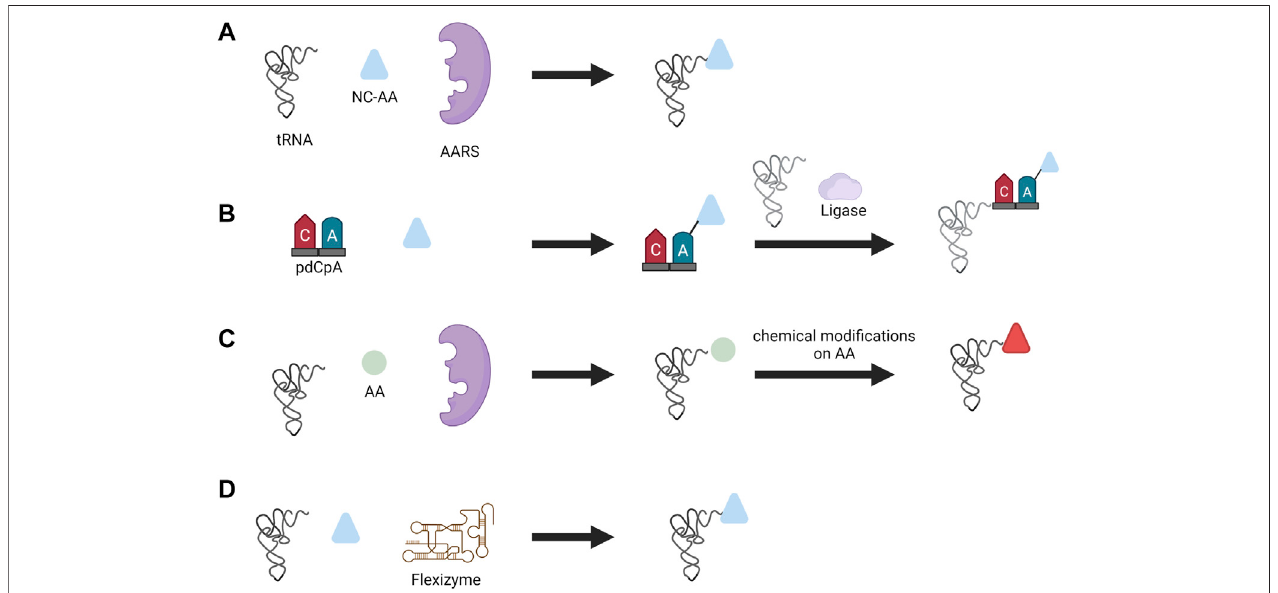
FIGURE 5 | Different aminoacylation methods used for NC-AA incorporation. (A) Enzymatic aminoacylation by AARS, (B) chemoenzymatic method, (C) chemical method, and (D) fl exizyme method.